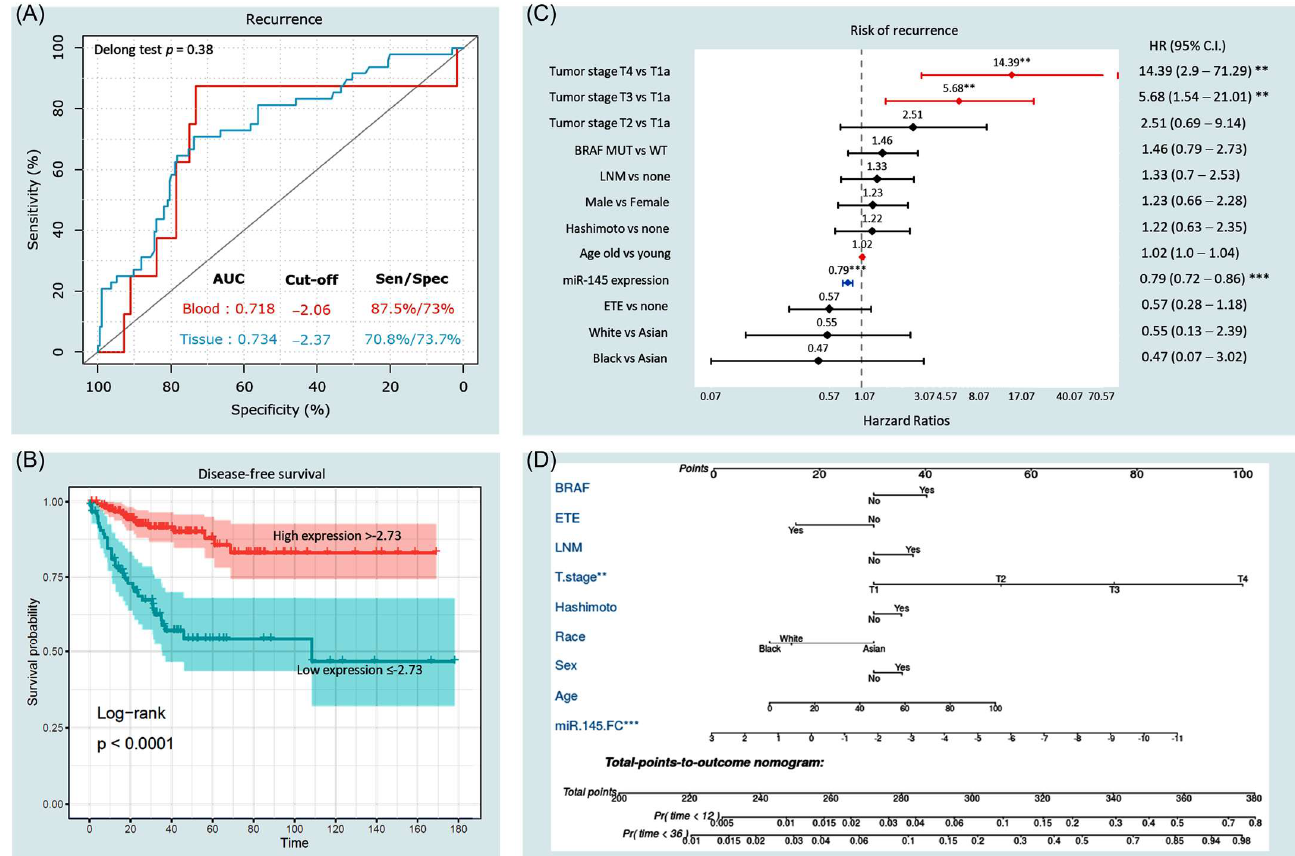
Figure 7. Prognostic value of miR-145 expression. ( A ) Receiver operator characteristic analysis for the role of miR-145-5p in tissues and blood. Area under the curve (AUC) is reported. Sen: sensitivity; spec: specificity. ( B ) Kaplan–Meier survival curve analysis for disease-free survival. Log fold changes in miR-145 in tissues were split into high and low expression groups based on the optimum cutoff value of ROC analysis. Log-rank test was used. ( C ) Predictor risk factors for disease-free survival. Multivariate Cox proportionate hazard regression model was employed. The results are presented as hazard ratio and confidence interval. Red lines have a higher risk of recurrence, while blue lines represent a protective variable. ** indicates p < 0.01 and *** indicates p < 0.001. ( D ) Prognostic nomogram for predicting recurrence at the time of diagnosis. miR145: microRNA-145-5p expression level as log fold change; ETE: extrathyroidal extension; LNM: lymph node metastasis.